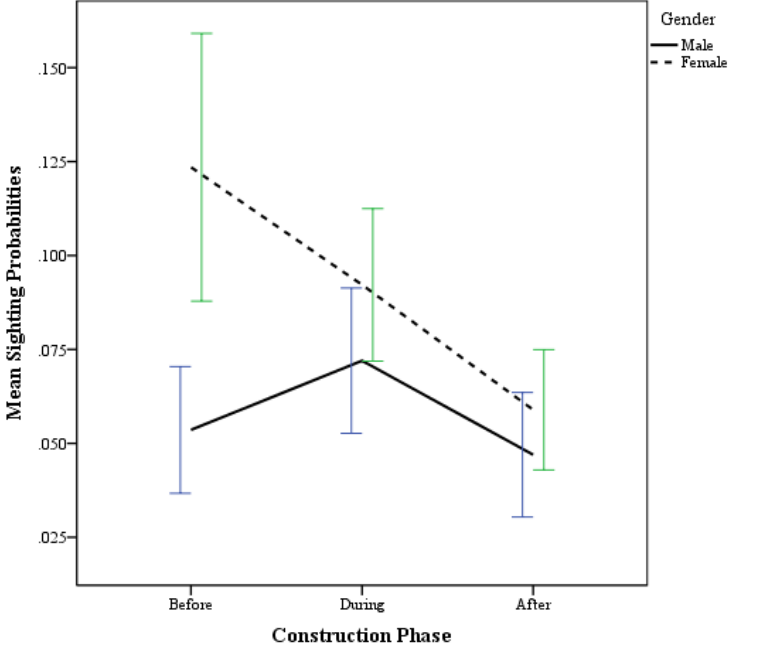
Figure 3. Mean sighting probabilities of adult male ( n = 28) and female ( n = 40) free-ranging bottlenose dolphins in John’s Pass across three phases of construction, N = 6504 total sightings. Error bars ± 2